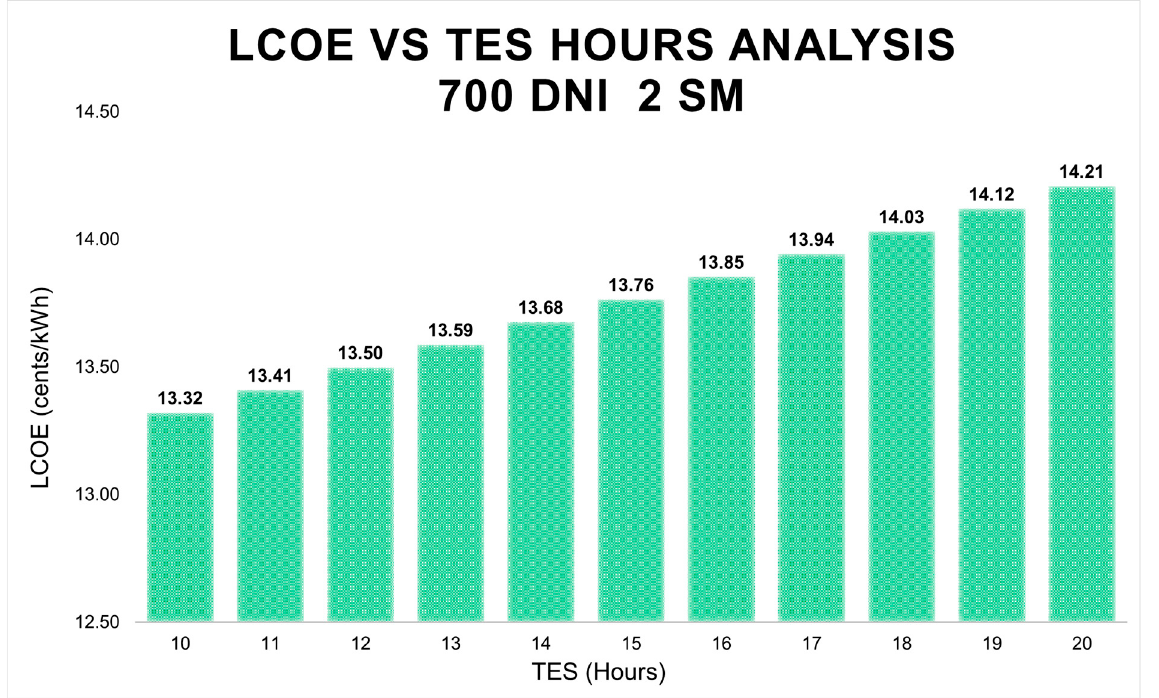
Figure 13. Optimization for 700 DNI and 2 SM.